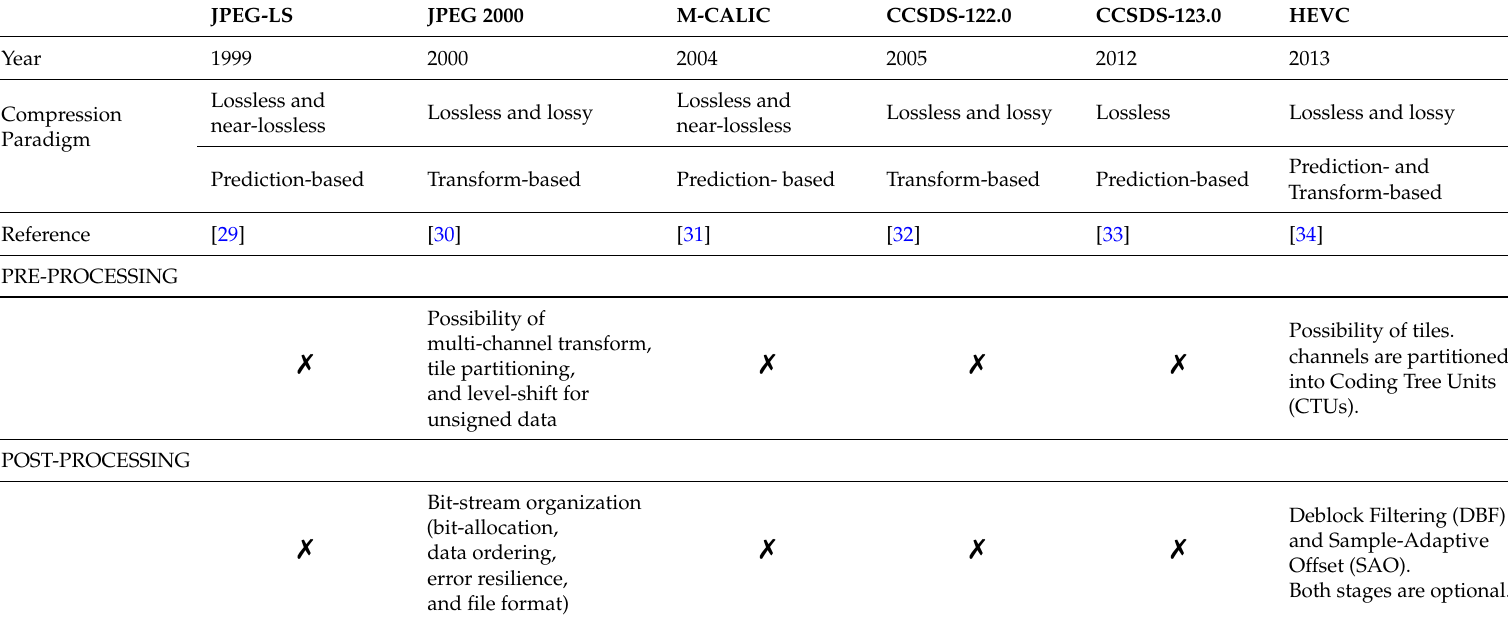
Table 2. Technical characteristics of the considered compression techniques (year, compression paradigm, reference, pre-processing, and